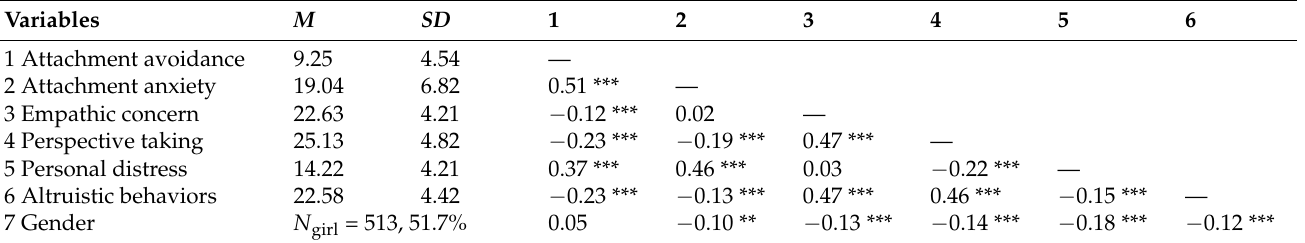
Table 1. Means, standard deviations, and bivariate correlations of attachment avoidance, attachment anxiety, empathic concern, perspective taking, personal distress, and altruistic